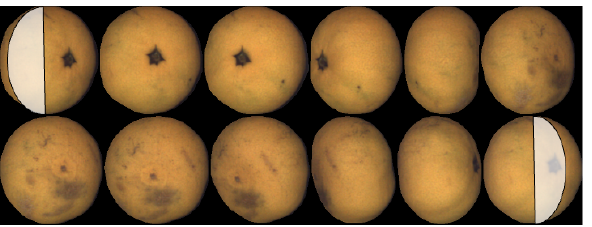
Figure 6. Portion of the first and last view corresponding to pre-roll and